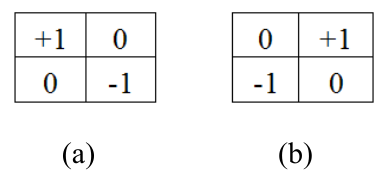
Figure 4. Roberts Cross convolution